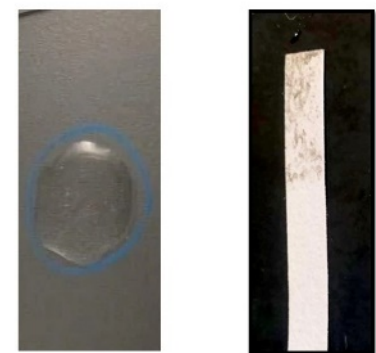
Figure 1. ( a ) Purple-colored cocci colonies observed after Gram staining of Enterococcus faecium KAE01. ( b ) Biochemical tests show that strain KAE01 is negative for catalase and oxidase, as no bubbles are formed and no purple stain is seen on the strip, respectively.